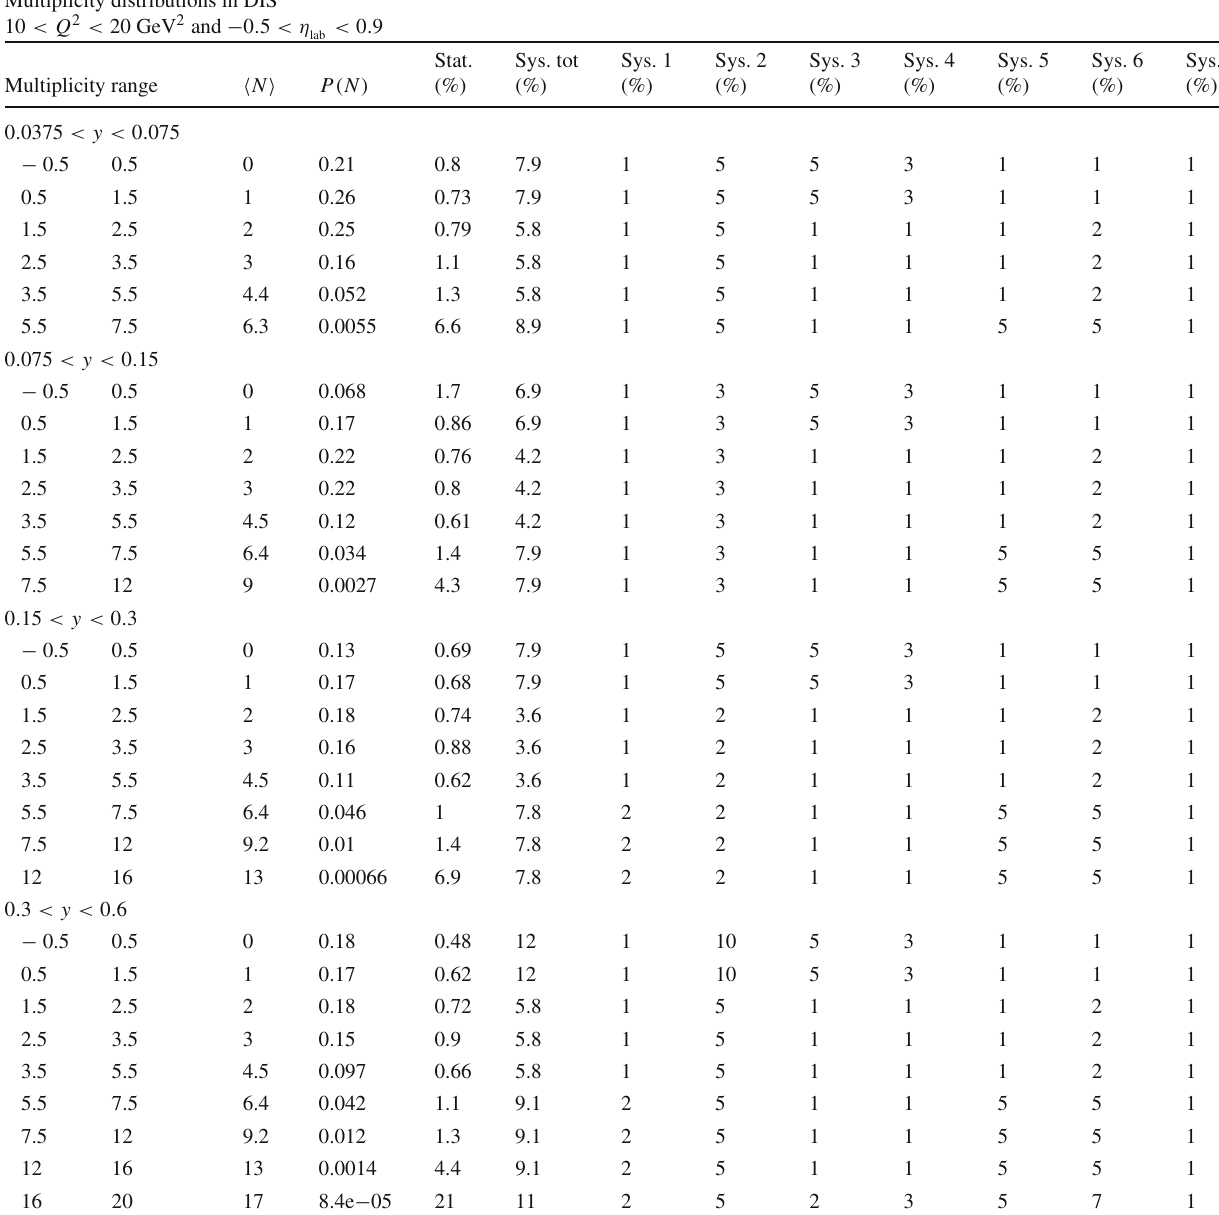
Table 17 Charged particle multiplicity distributions P ( N ) measured √ s = 319GeV with in the ranges of photon virtual- in ep DIS at ity 10 < Q 2 < 20 GeV 2 and charged particle pseudorapidity range Multiplicity distributions in DIS < 0 . 10 < Q 2 < 20 GeV 2 and − 0 . 5 < η lab